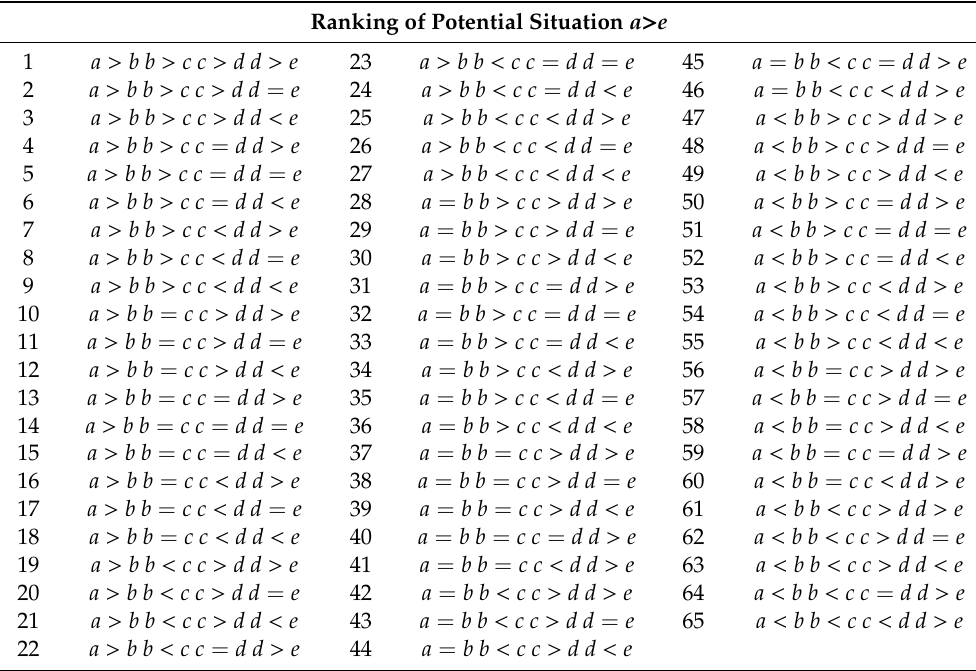
Table A1. The rank of five-element connection degree of similar